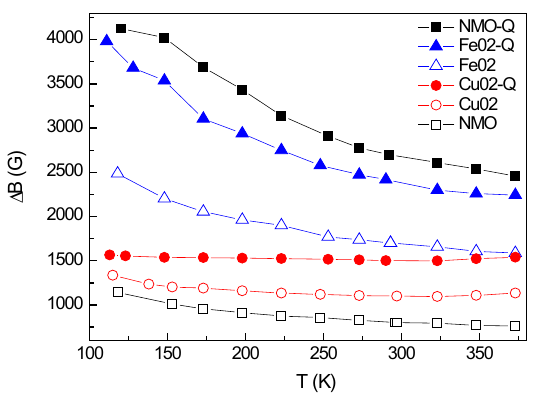
Figure 5. EPR linewidth values as a function of temperature for all the samples.